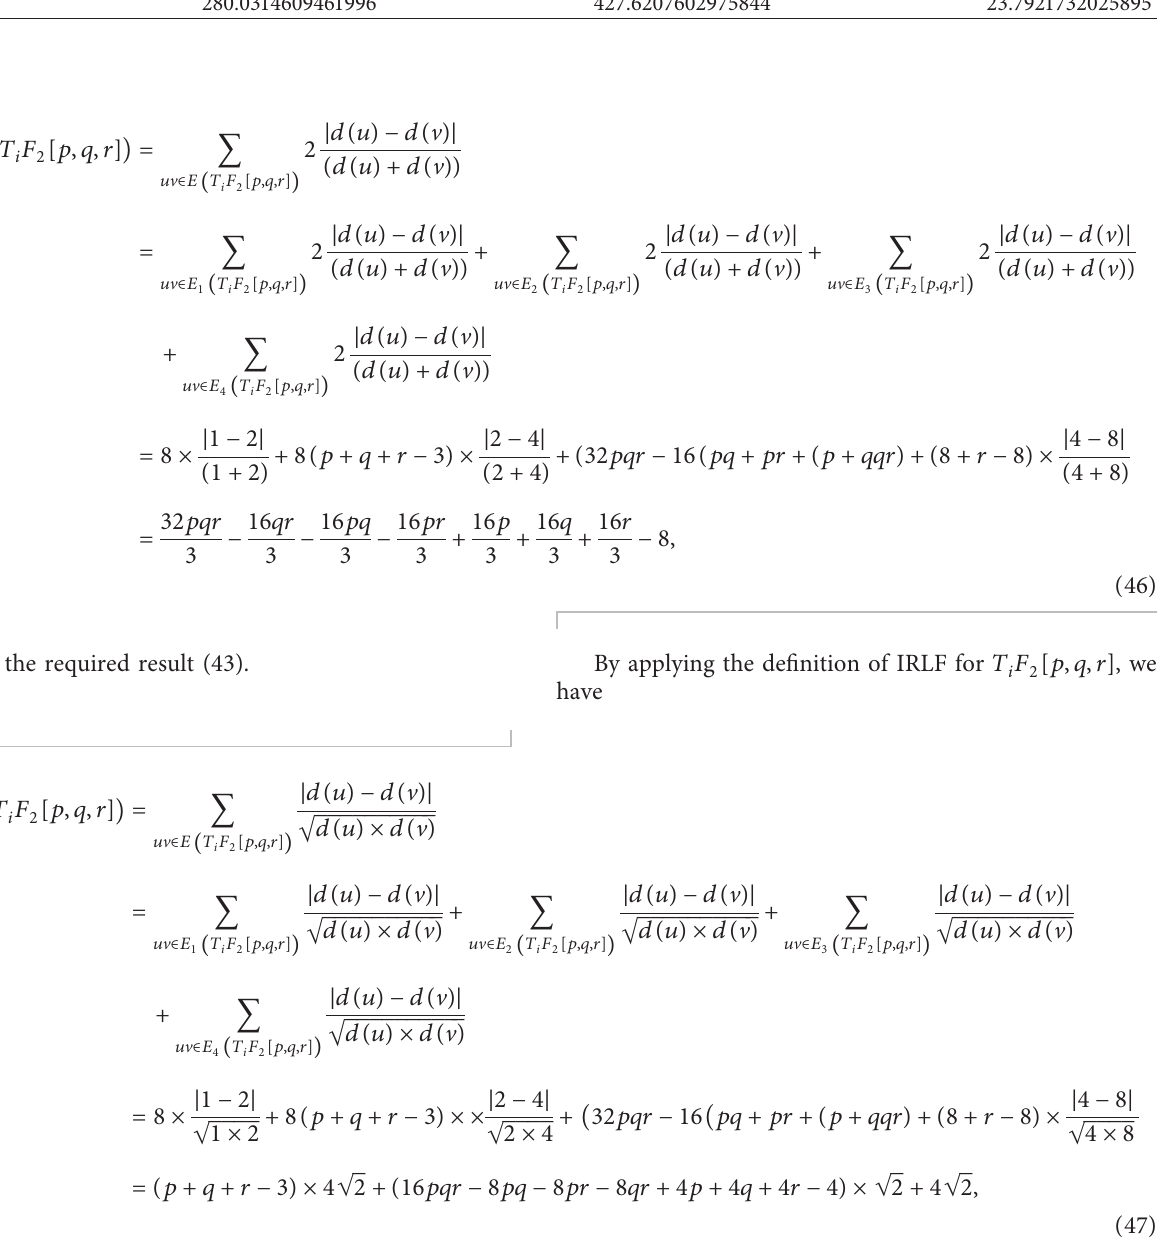
Table 3: Comparison of IRL , IRD